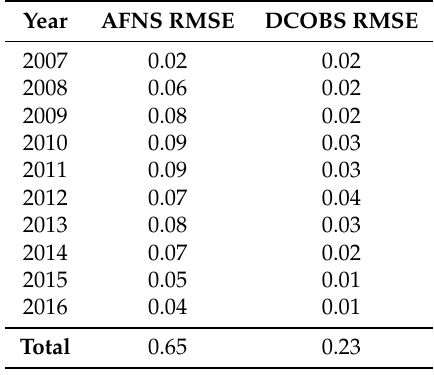
Table 1. Root of Mean Squared Errors for the AFNS and